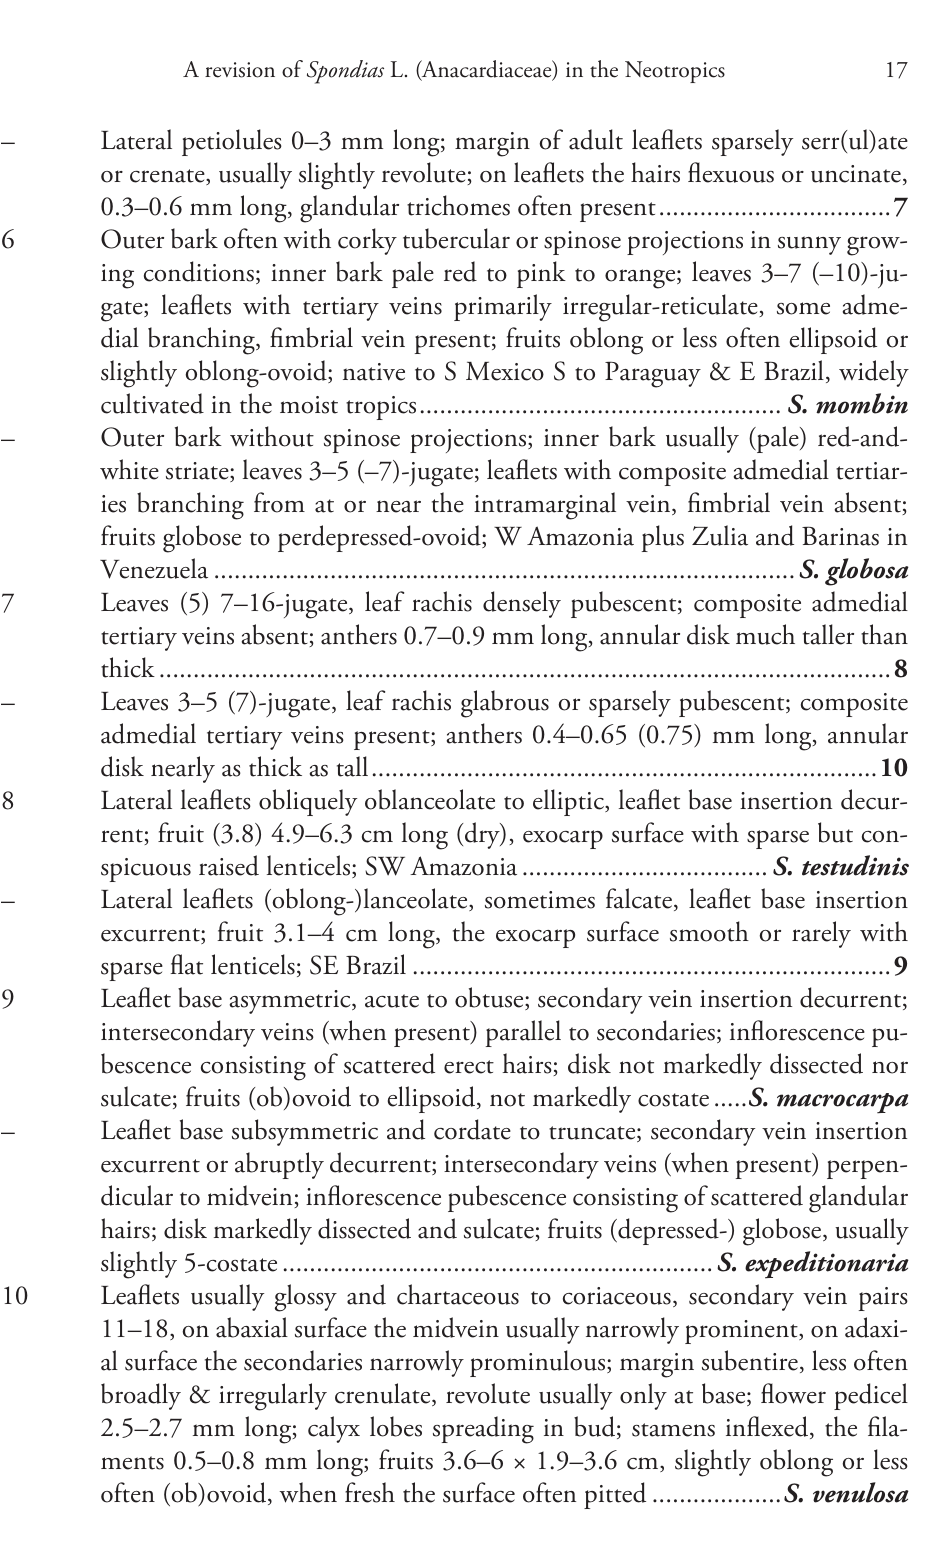
– Lateral petiolules 0–3 mm long; margin of adult leaflets sparsely serr(ul)ate or crenate, usually slightly revolute; on leaflets the hairs flexuous or uncinate, 0.3–0.6 mm long, glandular trichomes often present .................................. 7 6 Outer bark often with corky tubercular or spinose projections in sunny grow- ing conditions; inner bark pale red to pink to orange; leaves 3–7 (–10)-ju- gate; leaflets with tertiary veins primarily irregular-reticulate, some adme- dial branching, fimbrial vein present; fruits oblong or less often ellipsoid or slightly oblong-ovoid; native to S Mexico S to Paraguay & E Brazil, widely cultivated in the moist tropics ..................................................... S. mombin – Outer bark without spinose projections; inner bark usually (pale) red-and- white striate; leaves 3–5 (–7)-jugate; leaflets with composite admedial tertiar- ies branching from at or near the intramarginal vein, fimbrial vein absent; fruits globose to perdepressed-ovoid; W Amazonia plus Zulia and Barinas in Venezuela ..................................................................................... S. globosa 7 Leaves (5) 7–16-jugate, leaf rachis densely pubescent; composite admedial tertiary veins absent; anthers 0.7–0.9 mm long, annular disk much taller than thick ........................................................................................................... 8 – Leaves 3–5 (7)-jugate, leaf rachis glabrous or sparsely pubescent; composite admedial tertiary veins present; anthers 0.4–0.65 (0.75) mm long, annular disk nearly as thick as tall .......................................................................... 10 8 Lateral leaflets obliquely oblanceolate to elliptic, leaflet base insertion decur- rent; fruit (3.8) 4.9–6.3 cm long (dry), exocarp surface with sparse but con- spicuous raised lenticels; SW Amazonia .................................... S. testudinis – Lateral leaflets (oblong-)lanceolate, sometimes falcate, leaflet base insertion excurrent; fruit 3.1–4 cm long, the exocarp surface smooth or rarely with sparse flat lenticels; SE Brazil ...................................................................... 9 9 Leaflet base asymmetric, acute to obtuse; secondary vein insertion decurrent; intersecondary veins (when present) parallel to secondaries; inflorescence pu- bescence consisting of scattered erect hairs; disk not markedly dissected nor sulcate; fruits (ob)ovoid to ellipsoid, not markedly costate ..... S. macrocarpa – Leaflet base subsymmetric and cordate to truncate; secondary vein insertion excurrent or abruptly decurrent; intersecondary veins (when present) perpen- dicular to midvein; inflorescence pubescence consisting of scattered glandular hairs; disk markedly dissected and sulcate; fruits (depressed-) globose, usually slightly 5-costate ............................................................... S. expeditionaria 10 Leaflets usually glossy and chartaceous to coriaceous, secondary vein pairs 11–18, on abaxial surface the midvein usually narrowly prominent, on adaxi- al surface the secondaries narrowly prominulous; margin subentire, less often broadly & irregularly crenulate, revolute usually only at base; flower pedicel 2.5–2.7 mm long; calyx lobes spreading in bud; stamens inflexed, the fila- ments 0.5–0.8 mm long; fruits 3.6–6 × 1.9–3.6 cm, slightly oblong or less often (ob)ovoid, when fresh the surface often pitted ................... S.